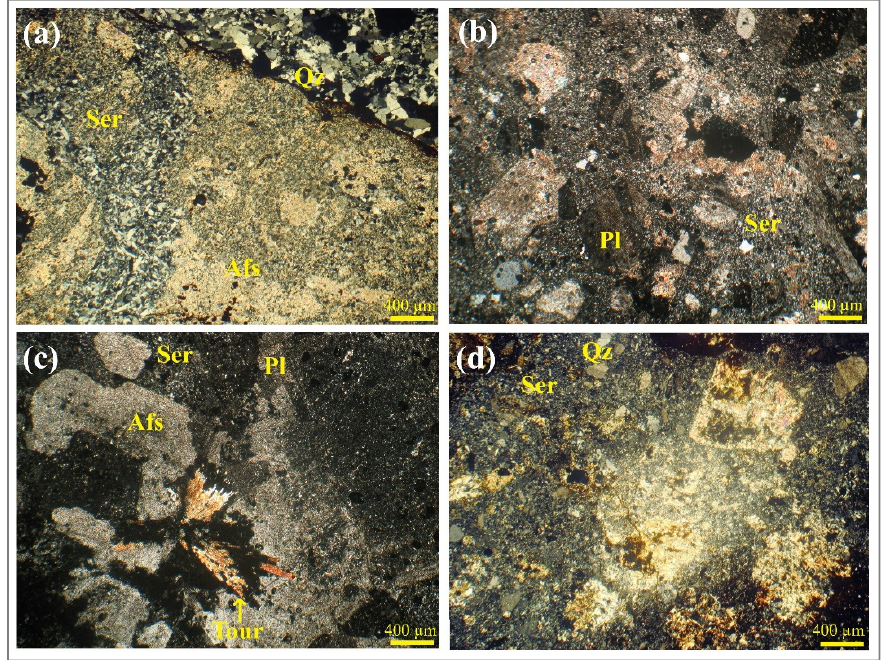
Figure 12. Thin sections of ( a ) the S04, ( b ) S07, ( c ) S13, and ( d ) S19 rock samples. The dusty surface of the images is due to the alteration and formation of clay and sericite minerals. Abbreviations: Ser = Serecite, and Qt = quartz, Afs = Alkali-feldspar, Pl = plagioclase, Tour = Tourmaline.